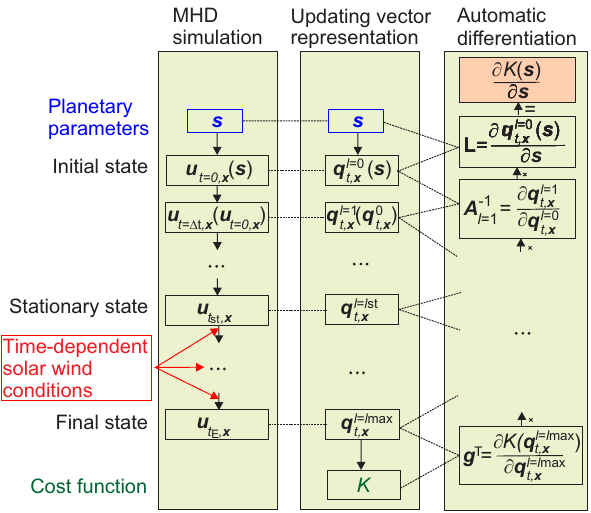
Figure 4. The left column sketches the time iteration of the MHD simulation code starting from the initial state at t = 0 determined by the planetary magnetic field parameters s . At a certain time step, a stationary solution u st , x is obtained and time iteration continues us- ing time-dependent solar wind conditions until the simulation ends at u t . In the middle column, the corresponding interpretation of E , x updating the complete time- and spatially dependent solution vector q t, x is presented. The cost function K is calculated from the final vector. On the right side, the automatic differentiation gradient cal- culation is presented, starting from the bottom and multiplying each factor according to Eq.